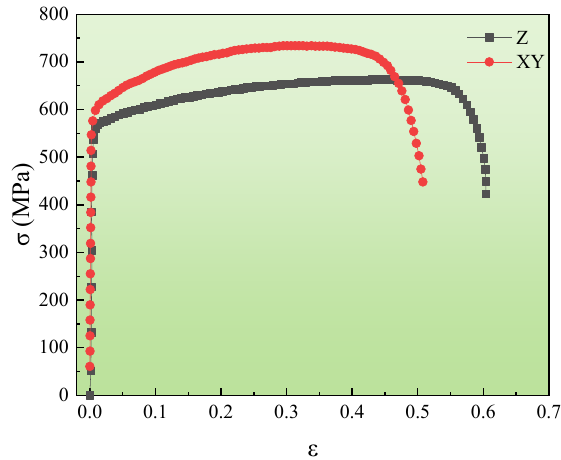
Figure 9. Engineering stress-strain curve of the specimen.